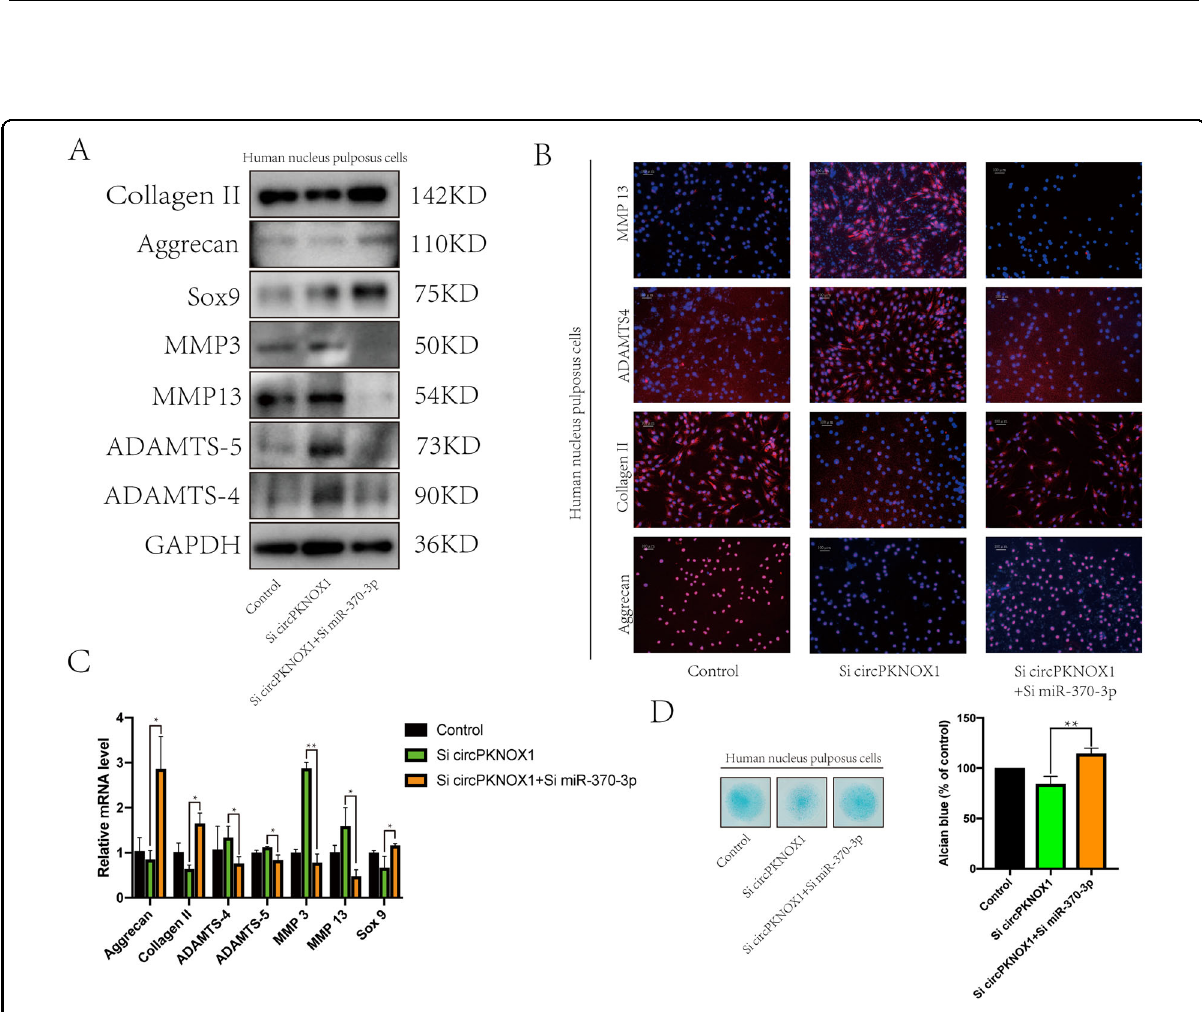
Fig. 4 circPKNOX1 regulated NP cells via miR-370-3p. A Expression of related proteins (collagen II, aggrecan, SOX9, MMP3, MMP13, ADAMTS4, and ADAMTS-5) was reversed. B The fl uorescence intensity of related proteins (collagen II, aggrecan, ADAMTS4, and MMP13) was observed via an immuno fl uorescence assay (scale bar, 100 μ m). C RT-qPCR was used to detect the expression of related genes (collagen II, aggrecan, SOX9 , MMP3 , MMP13 , ADAMTS4 , and ADAMTS5 ); * P <0.05, ** P <0.01. Data represent mean±SD, and the P values were determined by a two-tailed unpaired Student ’ s t test. D Left: the extracellular matrix was detected by Alcian staining. Right: the Alcian staining was quantitatively analyzed. Data represent mean±SD, and the P values were determined by a two-tailed unpaired Student ’ s t